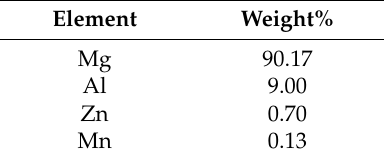
Table 1. AZ91 composition.